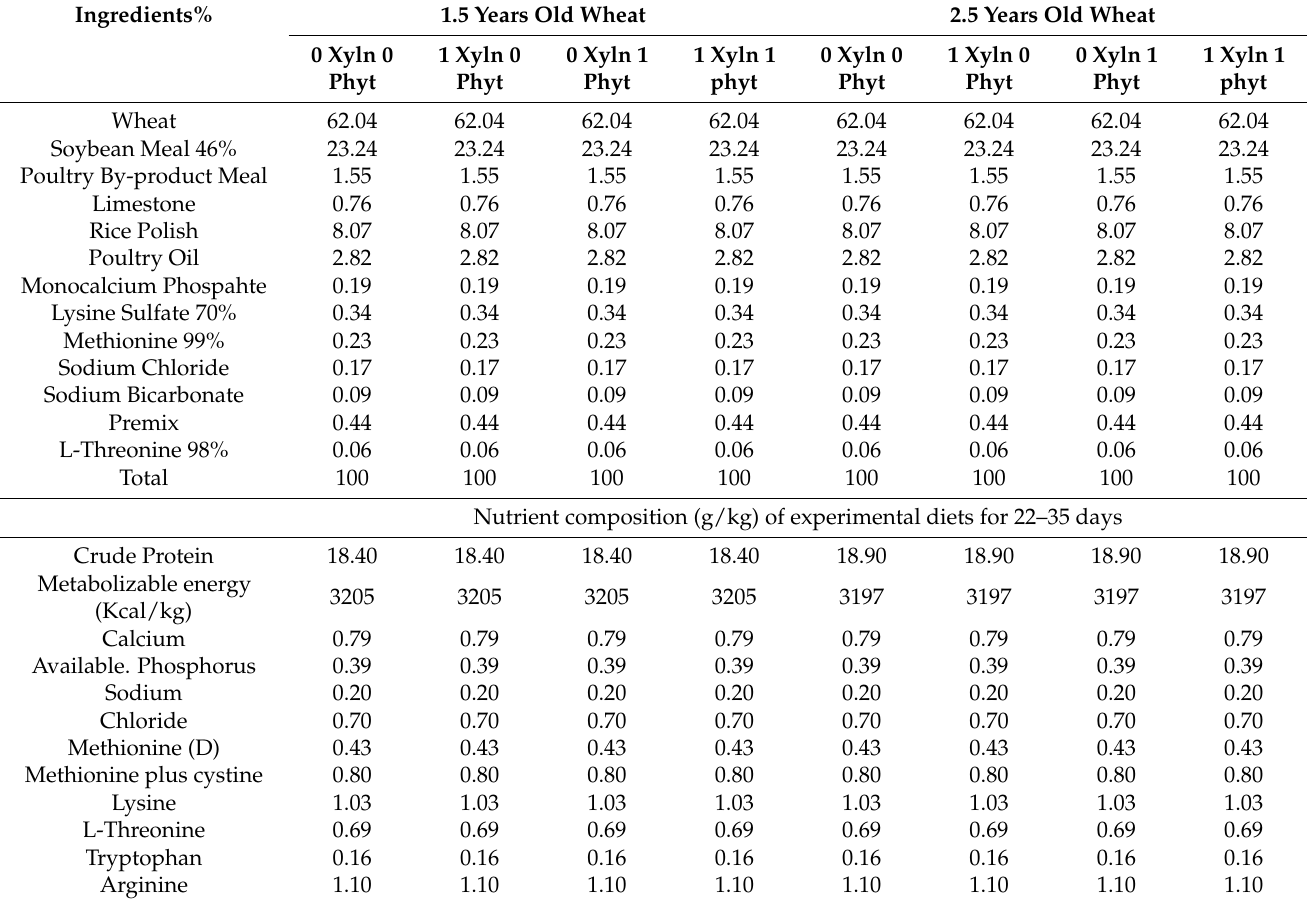
Table 2. Ingredients composition of experimental diets (% inclusion level) for finisher